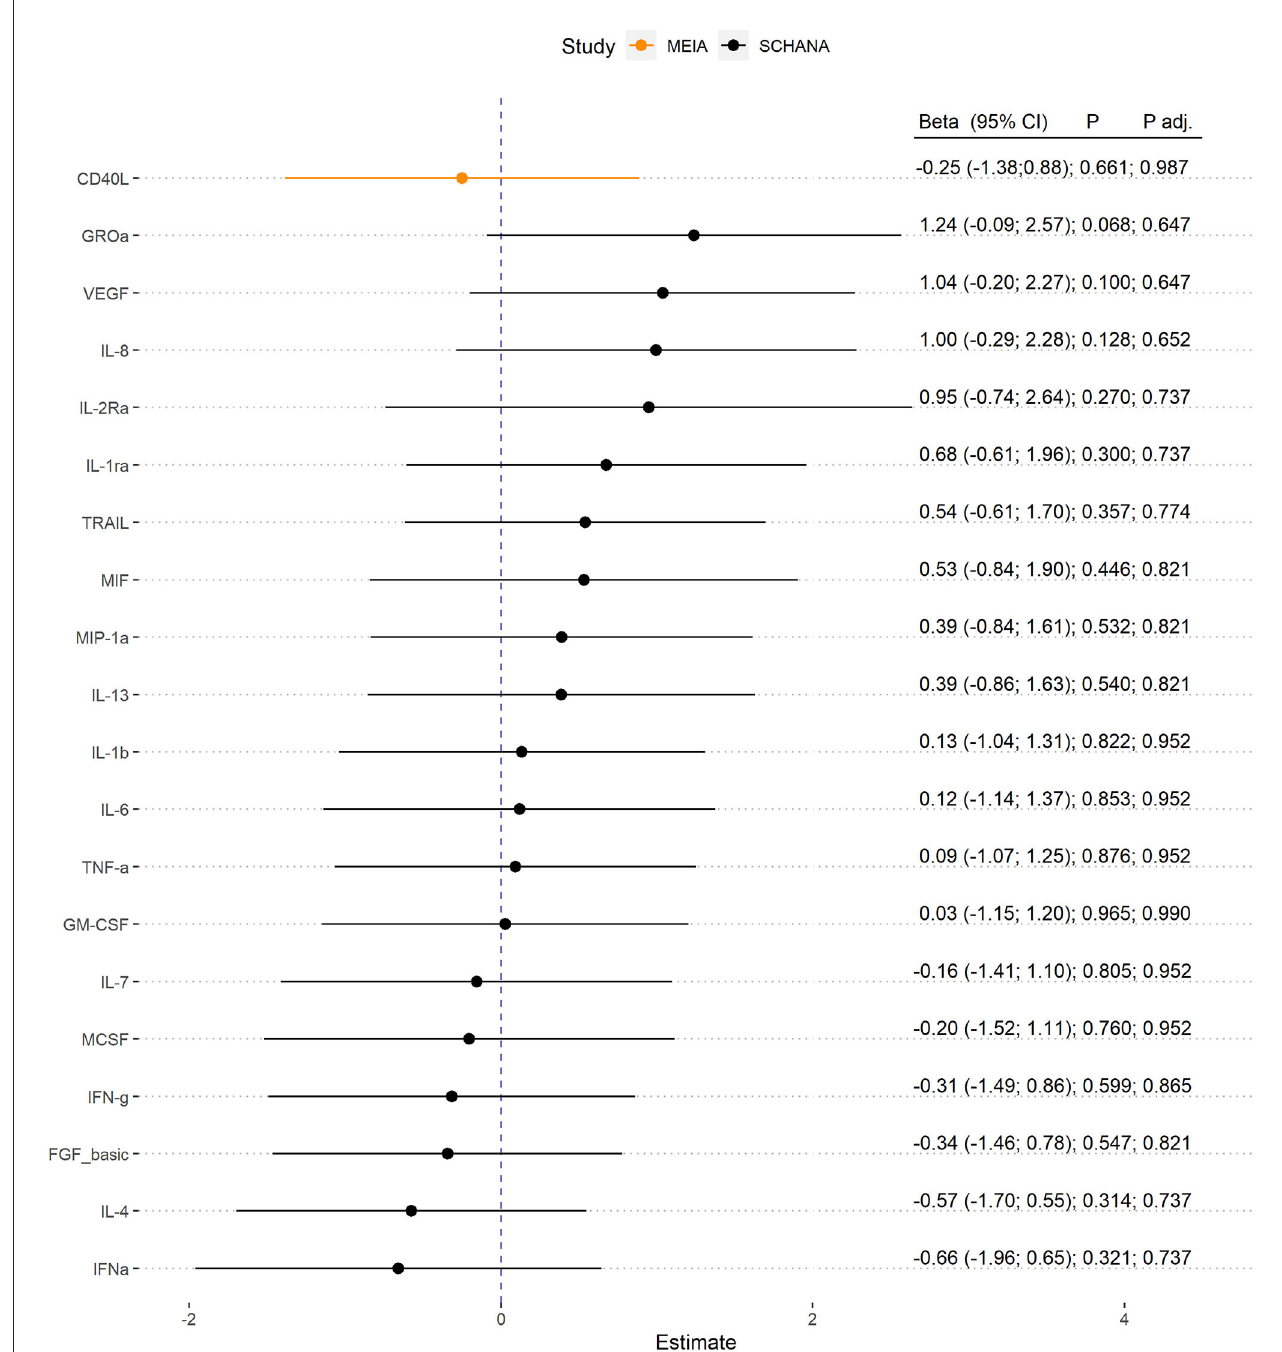
FIGURE2 Association of inflammation markers with fatigue. Biomarkers were only evaluable in 327 patients with stroke (SCHANA study) or 140 individuals from the general population (MEIA study).